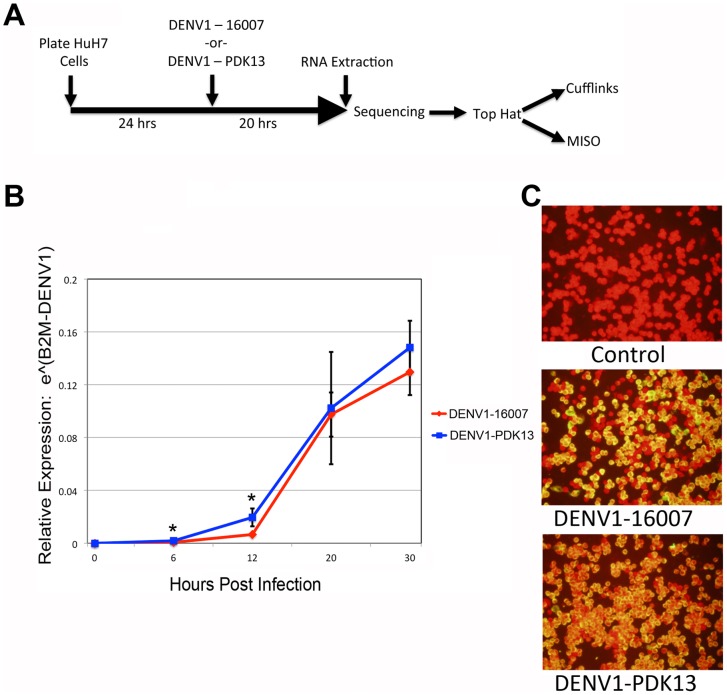
Experimental design and analysis of infection.
A. Timeline of experimental procedure and data analysis steps. B. Quantification of viral copy number normalized to the cellular B2M gene expression at 0, 6, 12, 20 and 30 hours post infection. Asterisks indicate a p-value of less than or equal to 0.05. C. Immunofluorescence analysis of Huh7 cells either mock-infected (top panel), infected with DENV1-16007 (middle panel) or DENV1- PDK13 (bottom panel) and probed with antibody against prM protein (2H2) followed by FITC-conjugated goat anti-mouse IgG at 20 h post-infection. The cell nuclei were counter-stained with Evan's Blue.